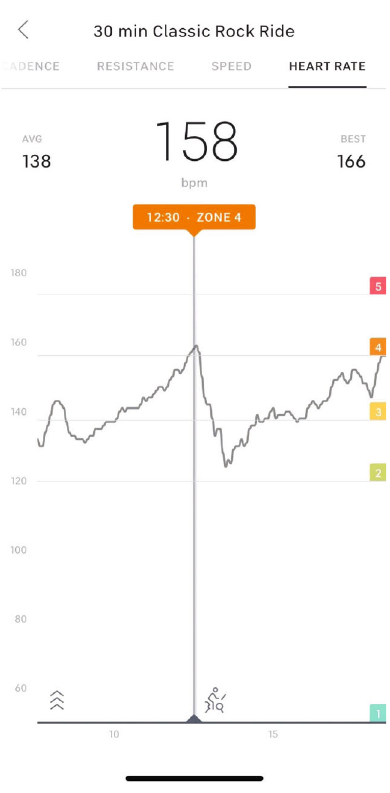
Figure 2: Example of heart rate data input from Bluetooth